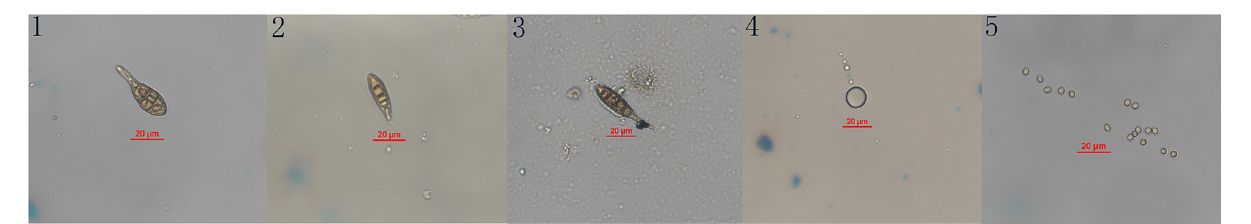
FIGURE 7 | Fungi remains recovered from Liangwangcheng dental residues.